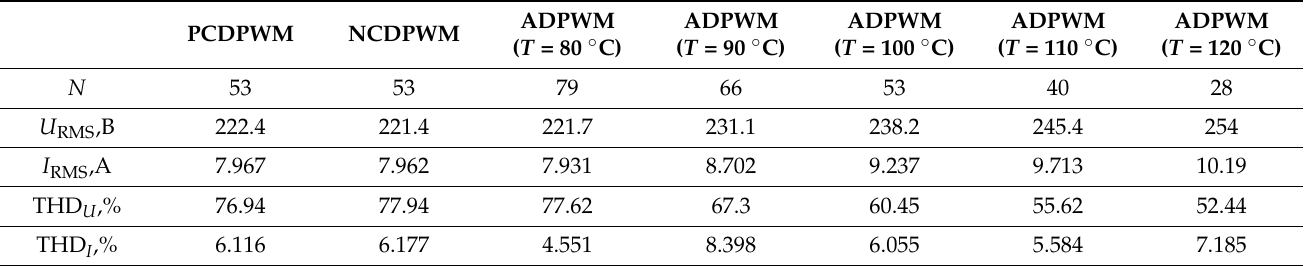
Table 5. Simulation results at MI = 0.8.